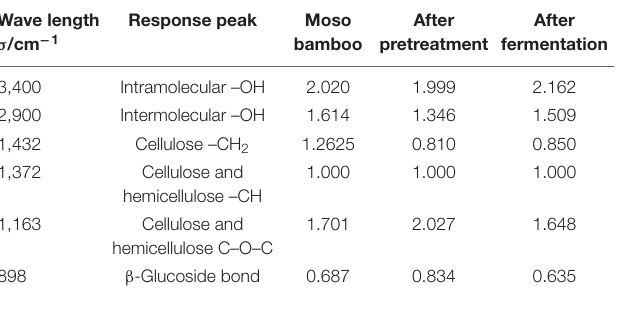
TABLE 2 | Structure attribution and relative intensity change of infrared absorption peak (Kim and Lee, 2005). Wave length σ /cm − 1